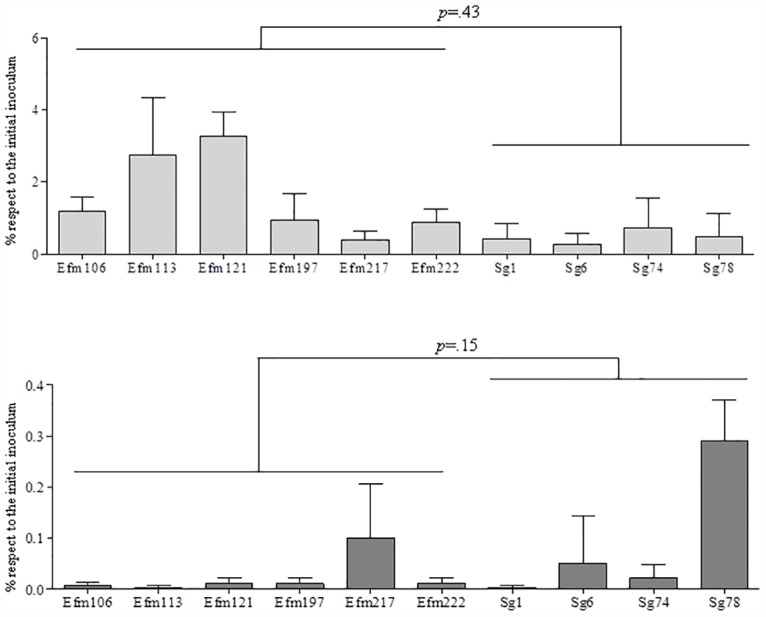
Bacterial adherence and invasion of epithelial Caco-2 cells.Adherence was analysed after 2 h of exposure while the viable internalized bacteria were counted after cell lysis. Results were presented as a percentage of the bacterial inocula and differences between the enterococcal and the streptococcal groups were compared using Mann Whitney U-test.